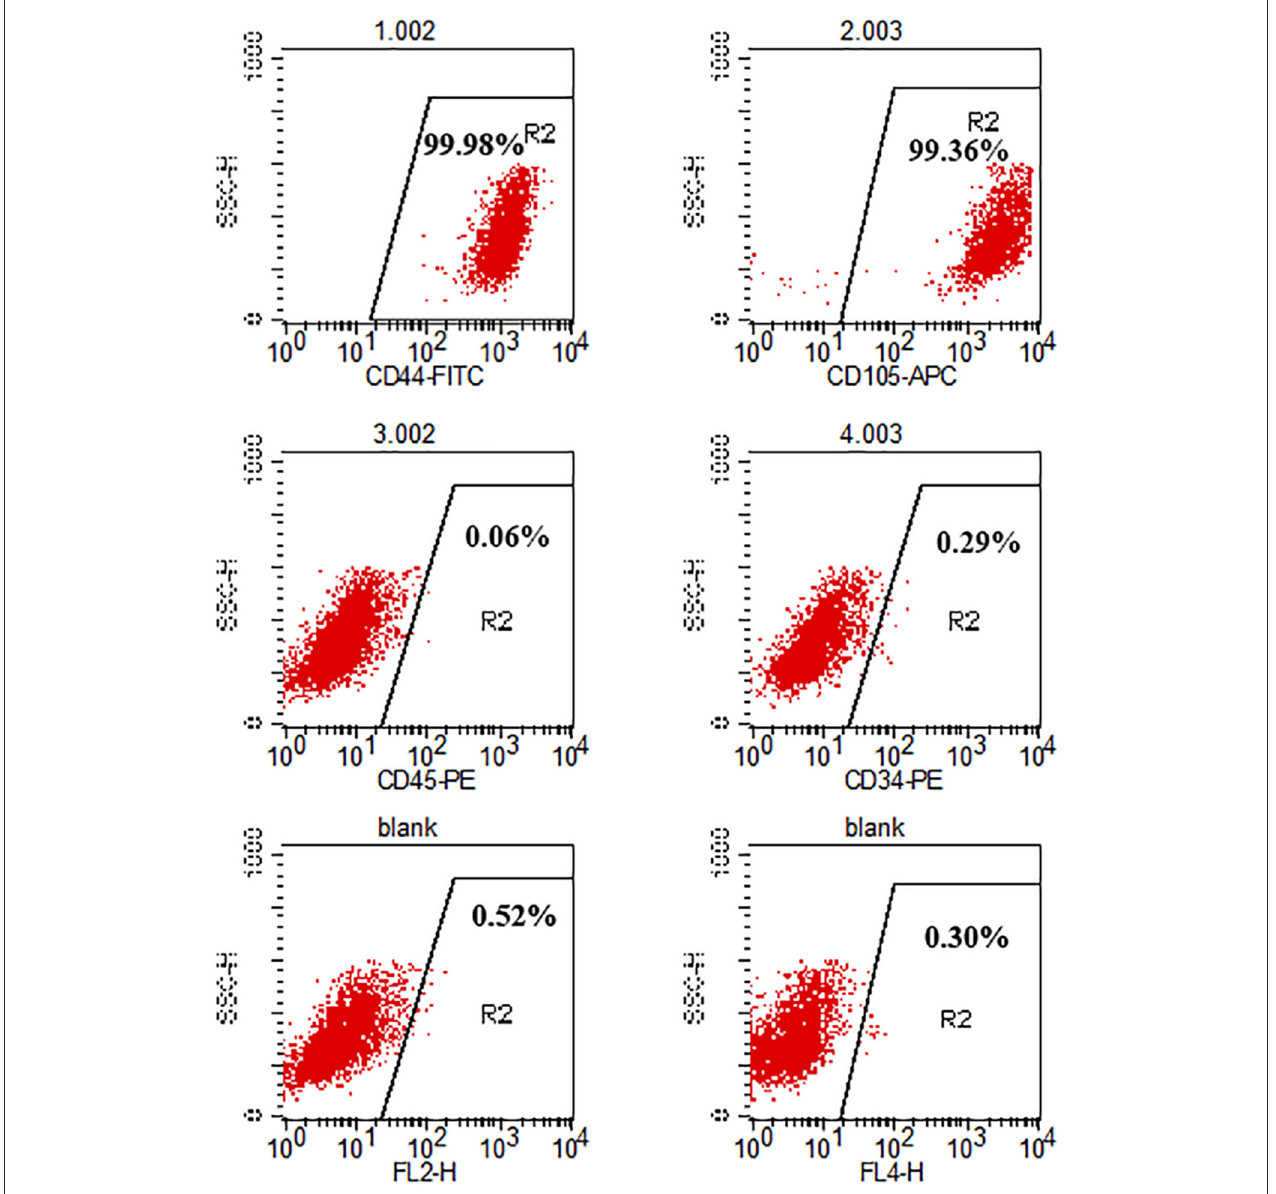
FIGURE 1 | Flow cytometry analysis of hADSC surface phenotype. CD44 and CD105 were positive while CD45 and CD34 were negative. The percentage of positive cells is indicated in the